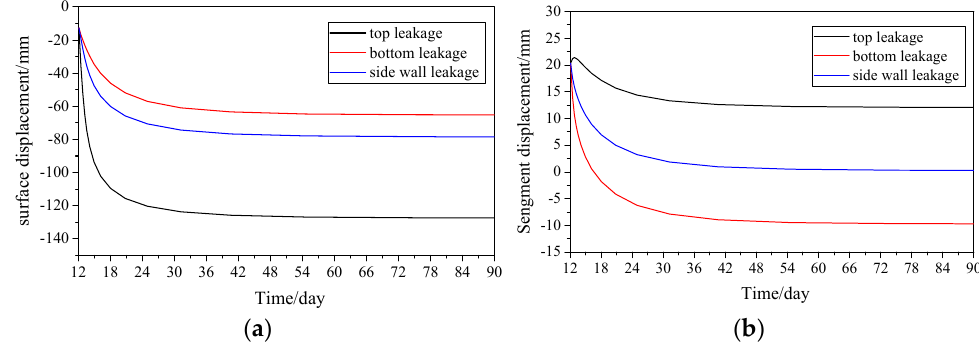
Figure 13. Displacement of surface and tunnel under different seepage points. ( a ) Development of surface displacement with time; ( b ) Development of segment displacement with time.